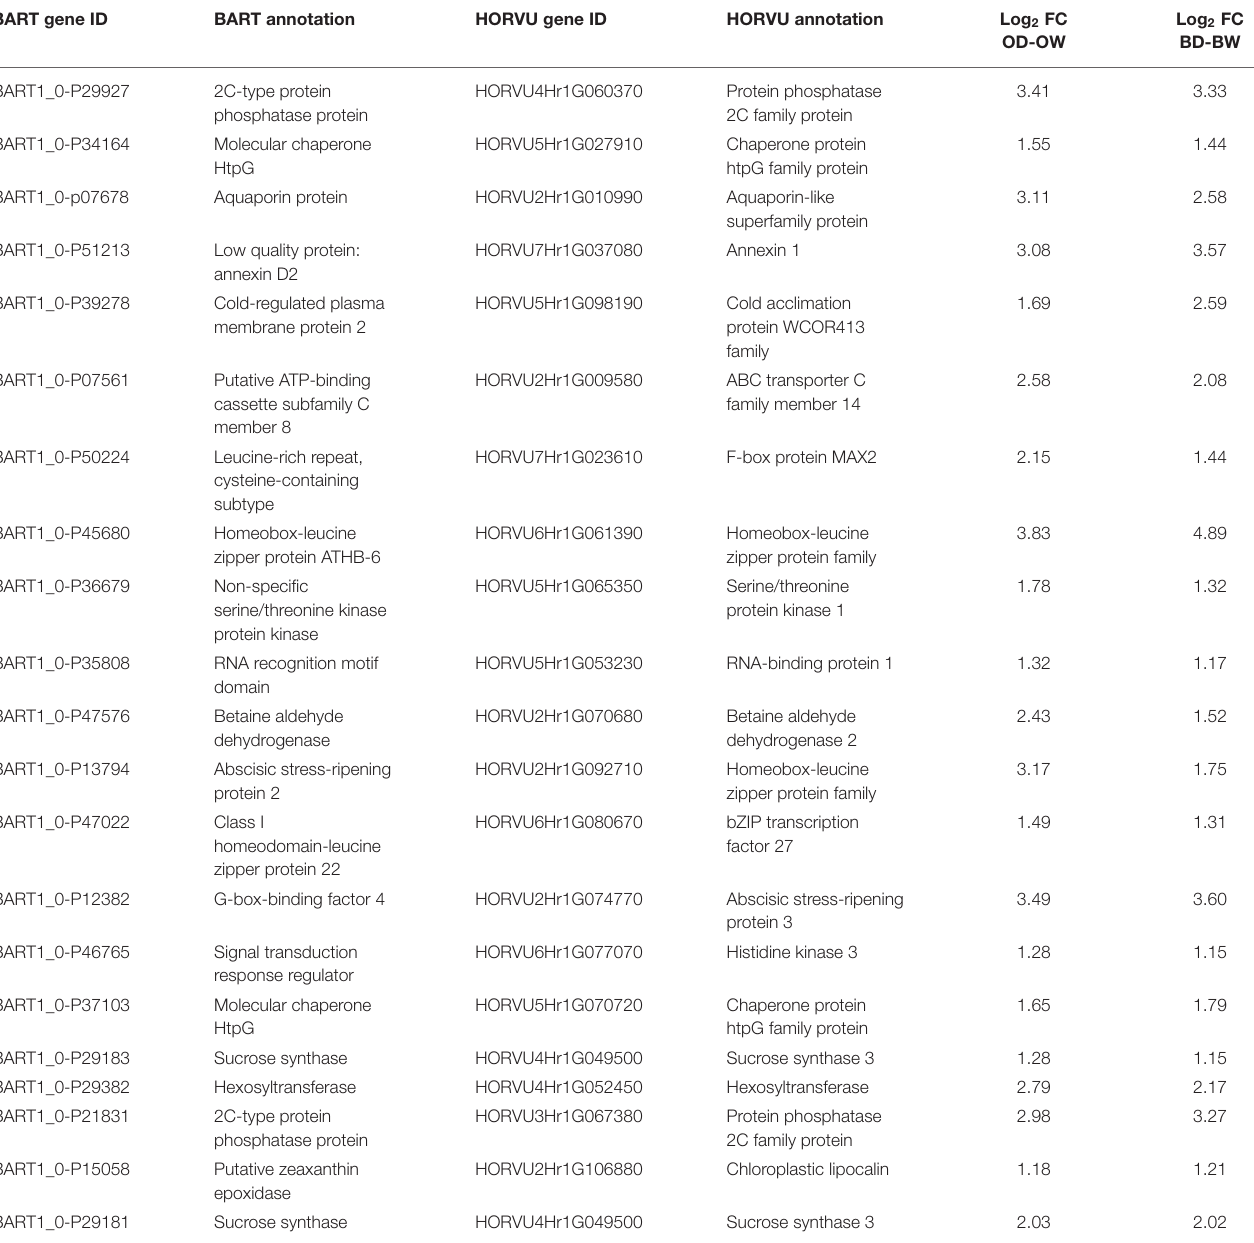
TABLE 3 | The BART and HORVU annotations of the commonly up-regulated genes under drought. BART gene